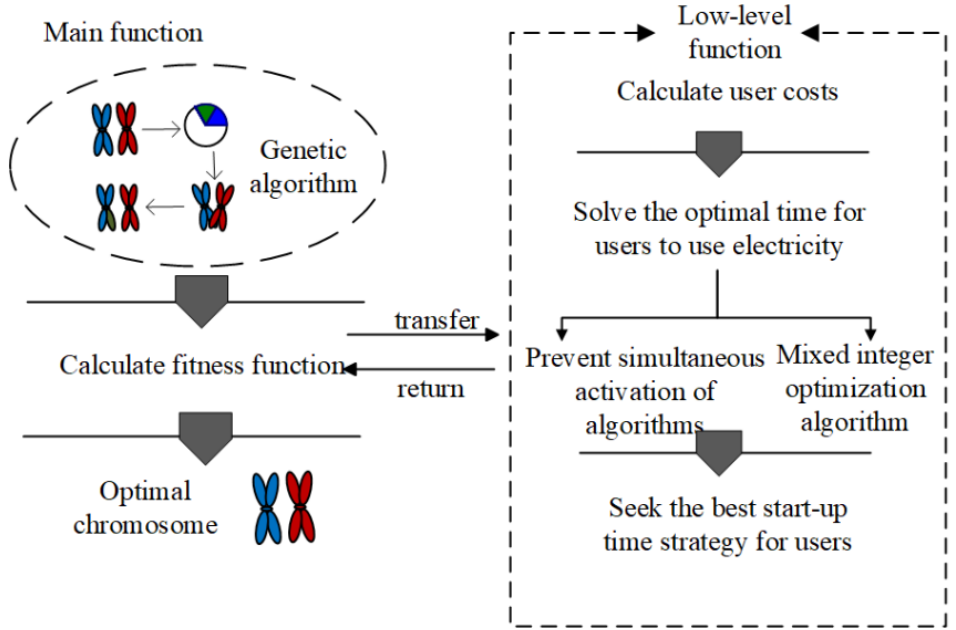
Figure 2. Flow chart of algorithm. Figure 3 is the detailed solution algorithm of the Stackelberg game model. In the main function, the genetic algorithm is used to search the strategy of the time of subsidy, and the value of the fitness function evaluates the quality of the strategy. First, the parameters are set. After the initial population is randomly generated, the individuals of the corresponding population are matched with each other in each generation. In the fitness function, the voltage of the distribution network is calculated by power flow, and the violation number is determined. If the value of the fitness function is not satisfied, then the next individual will continue to match the opponent until the optimal strategy is found. The process ends when the generation number is